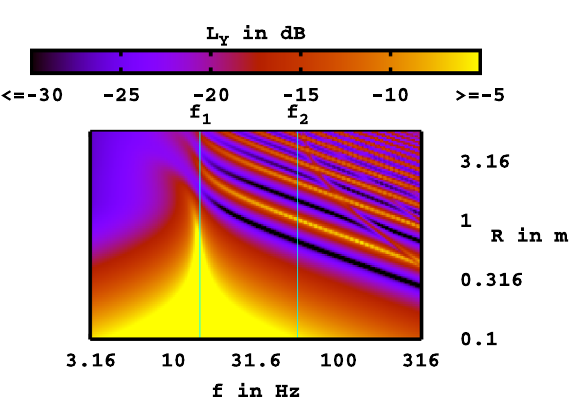
Figure 20. Level of admittance L Y according to (56); cyan marker lines for f 1 and f 2 ; r = 1.0 (cid:5) 10 5 Pa s/m 2 ; small blank upper right corner due to numerical